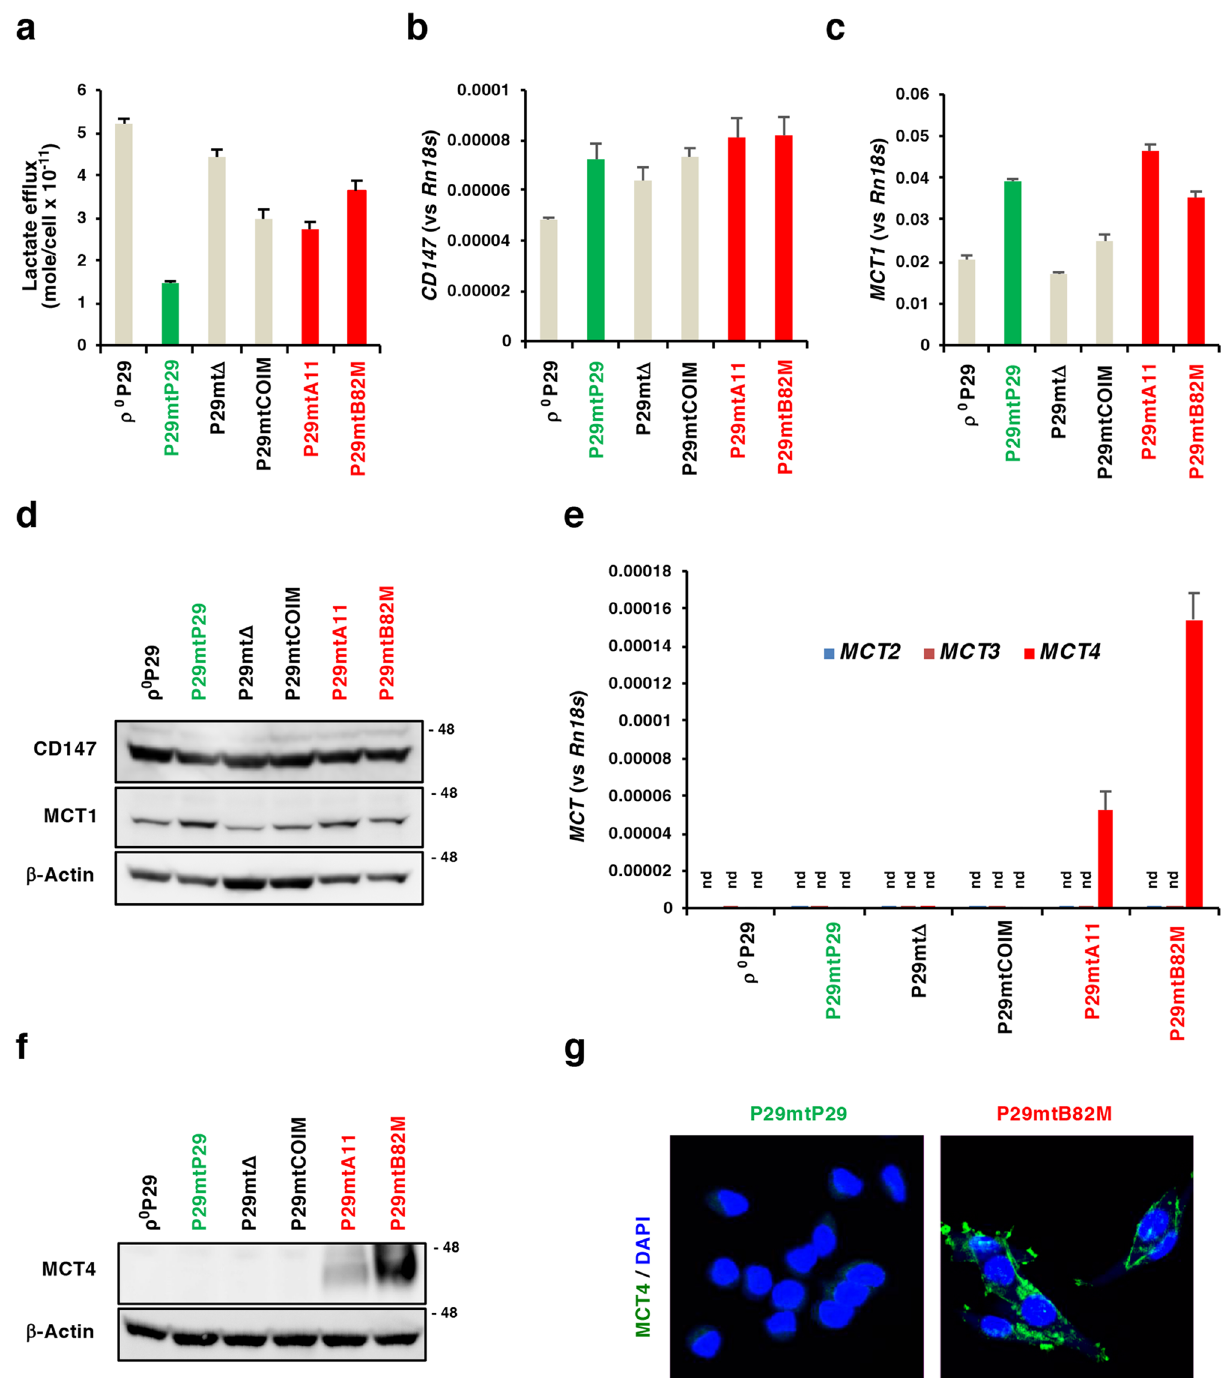
Figure 1. Lactate efflux and the expression of lactate transporter MCTs. ( a ) Lactate efflux by P29 cybrids. Error bar: SD. ( b ) RT-qPCR analysis of CD147 mRNA expression in P29 cybrids. Error bar: SD. ( c ) RT-qPCR analysis of MCT1 mRNA expression in P29 cybrids. Error bar: SD. ( d ) Western blot analysis of the expression of CD147 and MCT1 in P29 cybrids. β-Actin was used as a loading control. ( e ) RT-qPCR analysis of the expression of MCT2, MCT3 and MCT4 mRNA in P29 cybrids. nd: not detected. Error bar: SD. ( f ) Western blot analysis of the expression of MCT4 in P29 cybrids. β-Actin was used as a loading control. ( g ) Immunofluorescent staining of MCT4 in P29mtP29 and P29mtB82M cells. Uncropped Western blots images are shown in Supplementary Fig.